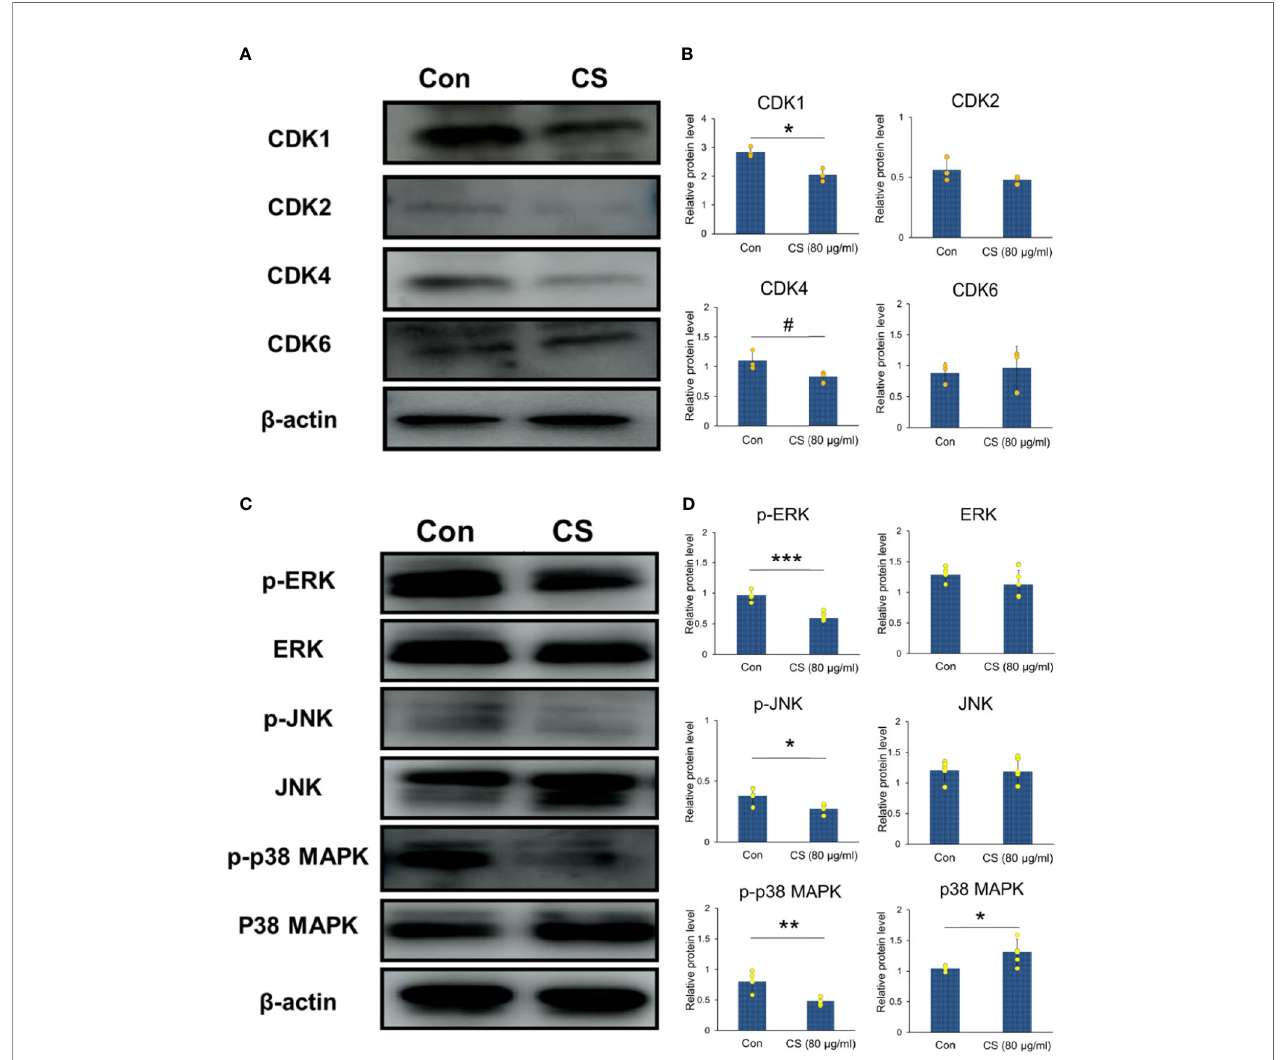
FIGURE 6 | CDKs and MAP kinase regulated by CS in HCT-116 cells. (A) Immunoblotting of CDK1, CDK2, CDK4, CDK6 and b -actin in HCT-116 cells ( b -actin was the internal control). (B) The protein levels of CDK1, CDK2, CDK4, and CDK6 (n = 3). (C) Immunoblotting of phosphorylated and unphosphorylated ERK, JNK, p38 MAPK, and b -actin in HCT-116 cells ( b -actin was the internal control). (D) The protein levels of p-ERK, p-JNK, p-p38 MAPK, ERK, JNK, and p38 MAPK (n = 5). The results are shown as the mean ± SEM. # p < 0.1; * p < 0.05; ** p < 0.01; *** p < 0.001 versus 0 m g/ml CS assessed using Student ’ s t -test. The results represent one of three (CDKs) or fi ve (MAPKs) independent experiments with similar